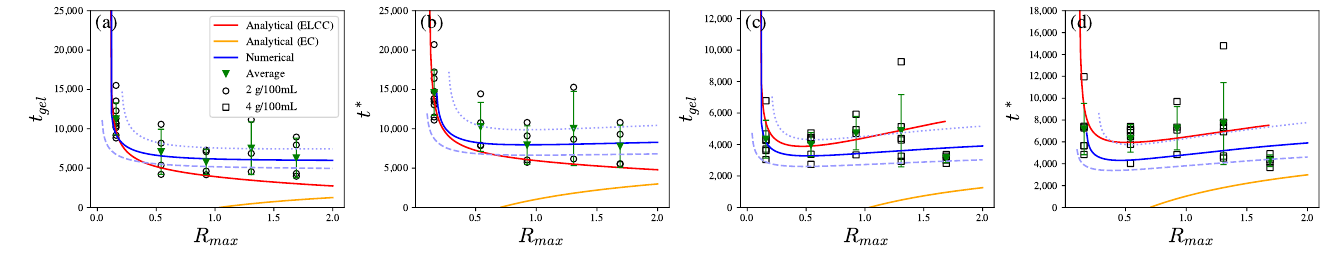
Figure 6. The predictions from Equations (29) and (30) of t gel and t ∗ for seed concentration [seed] = 2 g/100 mL in ( a , b ) and for 4 g/100 mL in ( c , d ). The lines show the numerical predic- tion (blue solid line), the analytical prediction for the enzyme-limited calcium binding controlled system (ELCC, red line), and the analytical prediction for enzyme-controlled system (EC, yellow line) The blue dotted and dashed lines show the influence of the slope uncertainties within 2.5 standard errors of the numerical